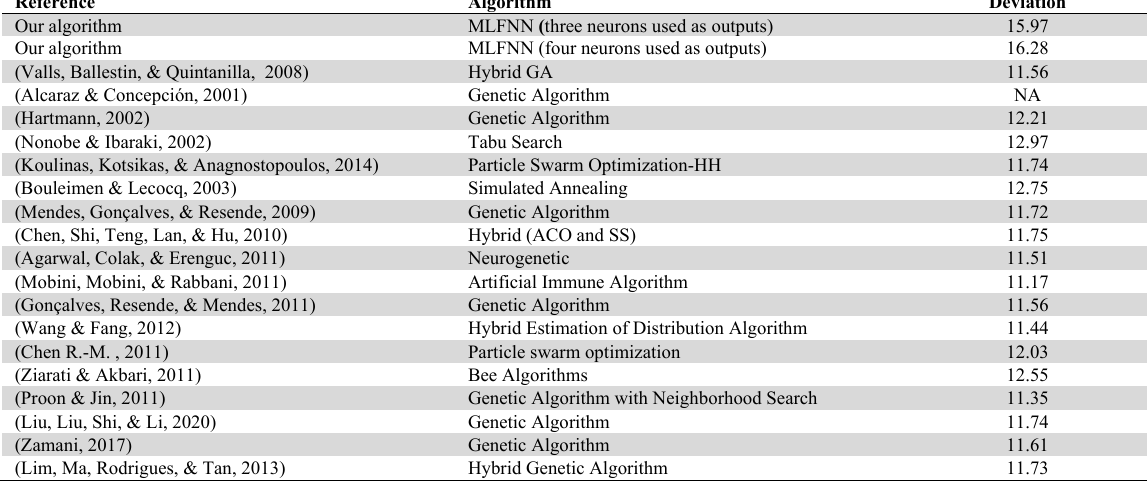
Percentage of average deviations from critical path lower bound for the J60